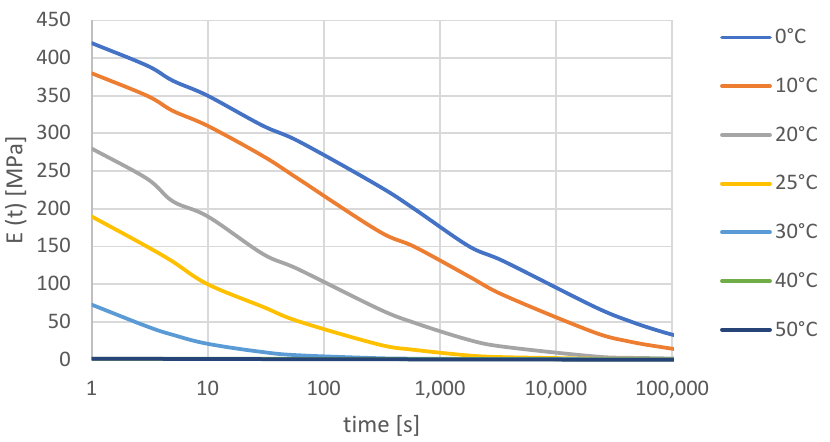
Figure 9. Young Relaxation curves for PVB Clear from Trosifol ® data sheet at different temperatures.